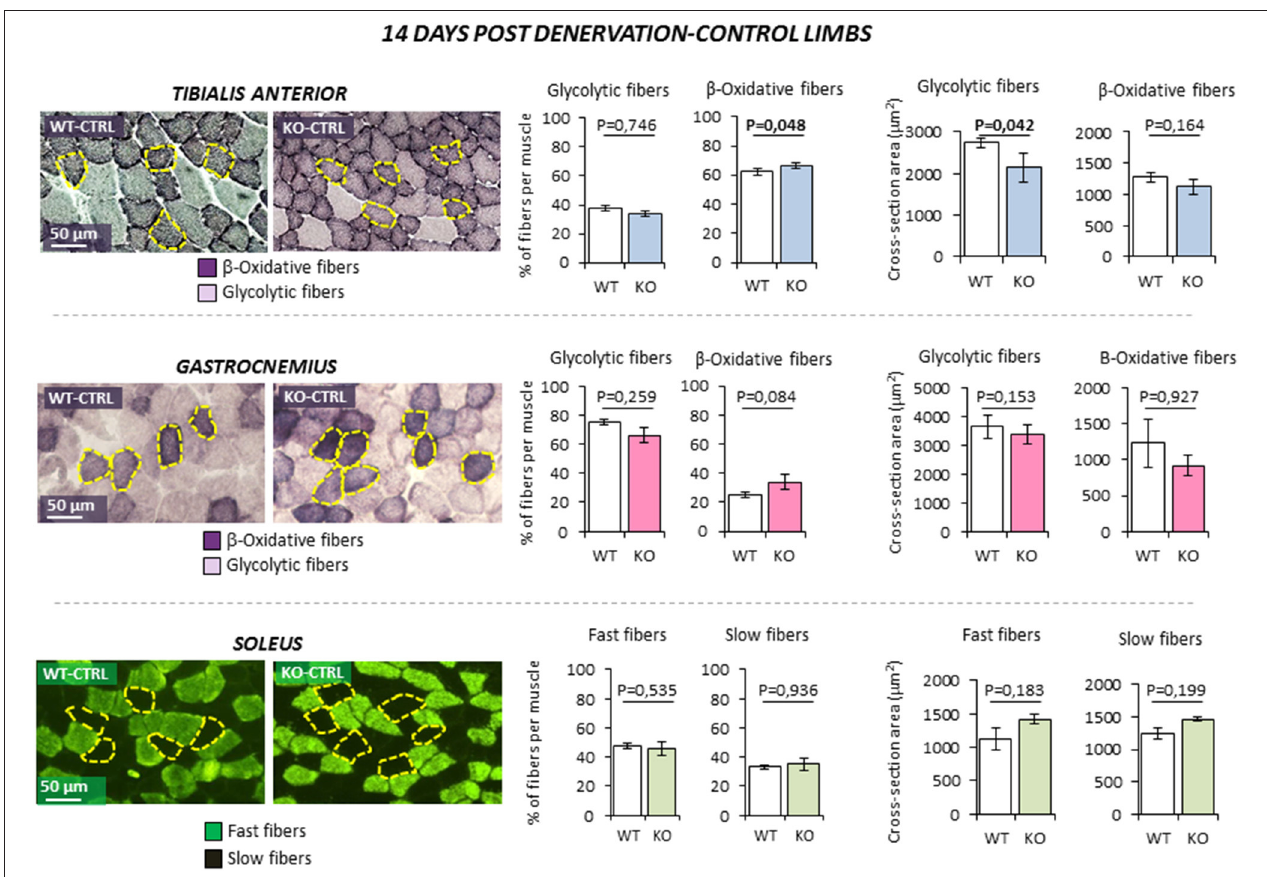
FIGURE 3 | Effect of leg denervation on fiber composition and cross section area in tibialis anterior , gastrocnemius, and soleus muscles in wild type (WT, N = 6) and Rxfp2 − / − mice (OK, N = 5). Results obtained in contralateral non-denervated control limbs (CTRL) are given after 14 days from denervation. Data in tibialis anterior , gastrocnemius muscle specimens were obtained by succinate-dehydrogenase (SDH) staining, distinguishing β -oxidative (purple) and glycolytic fibers (pale). Data in soleus muscle specimens were obtained by myosin-heavy chain immune-staining, distinguishing fast (green), and glycolytic fibers (dark). Representative microscopic fields are given. Results on fiber composition and cross section area are reported respectively as percentage of fiber-type per muscle and absolute fiber area ( µ m 2 ).Data are reported as mean values ± standard error of the mean. Significance: P -values between compared conditions are reported. Significant differences ( P < 0.05) are highlighted in